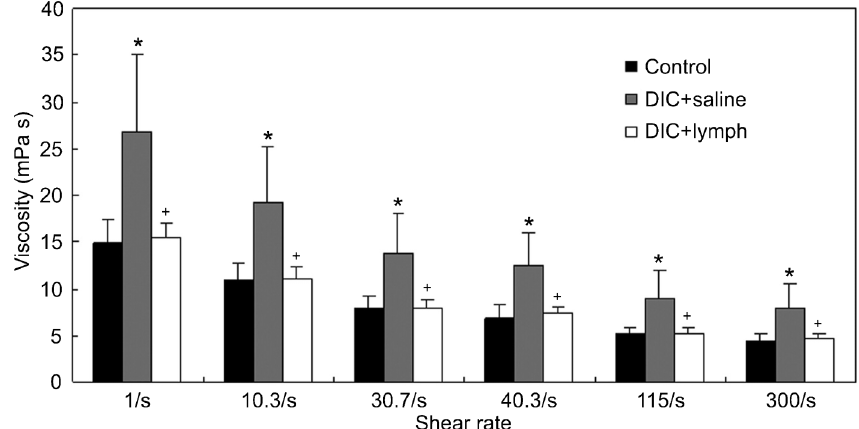
Figure 5. Changes of whole blood viscosity in the three rat groups studied. Data are reported as means ± SD in mPa s for 10 rats. *P , 0.05 compared to the control group; + P , 0.05 compared to the DIC + saline group (one-way ANOVA).